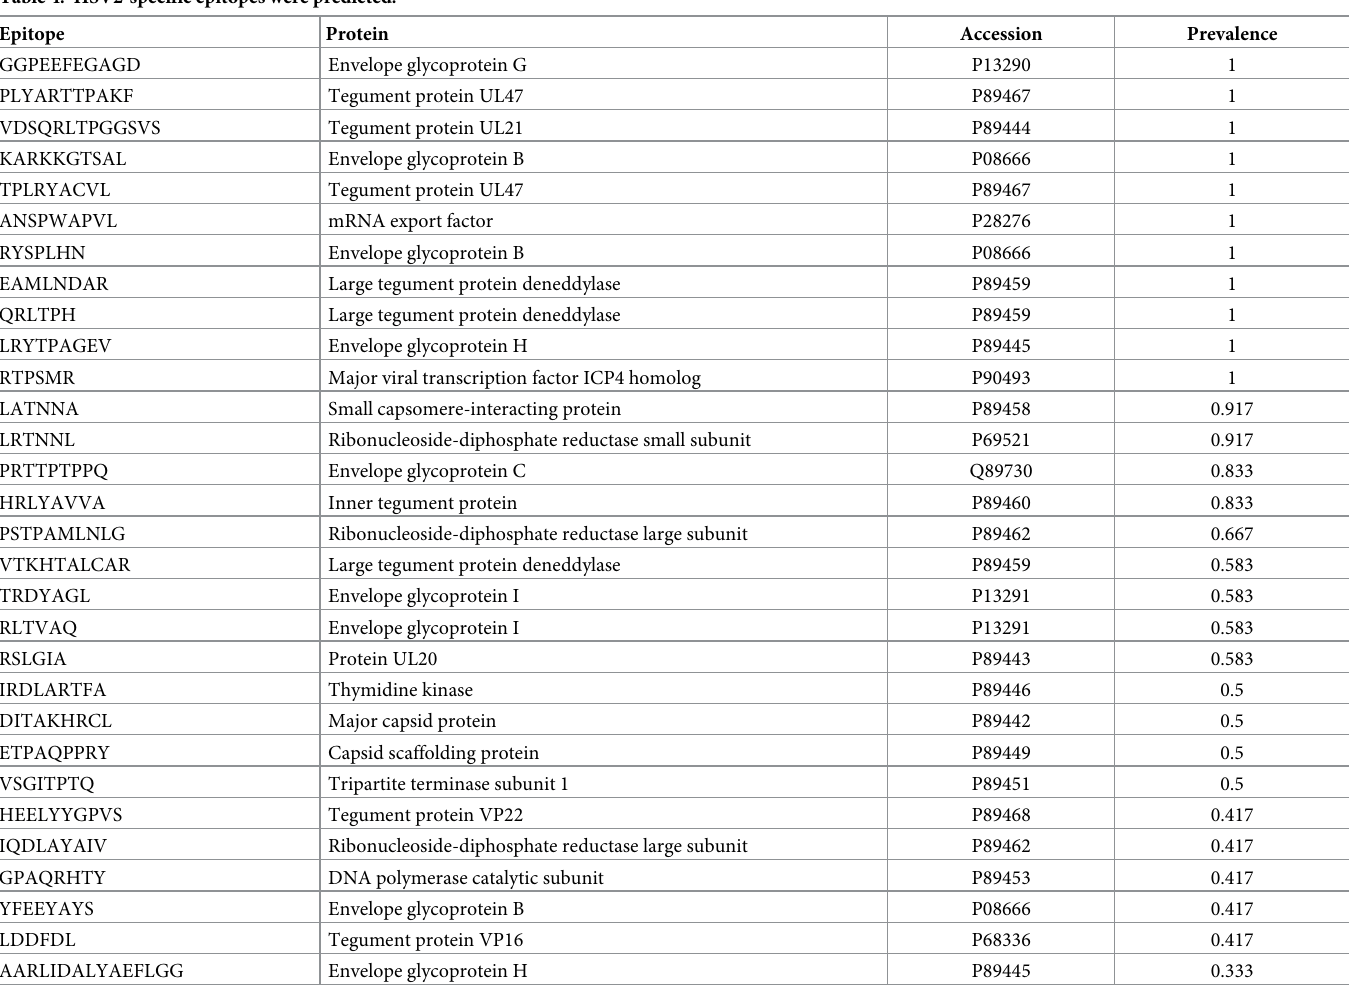
Table 4. HSV2-specific epitopes were